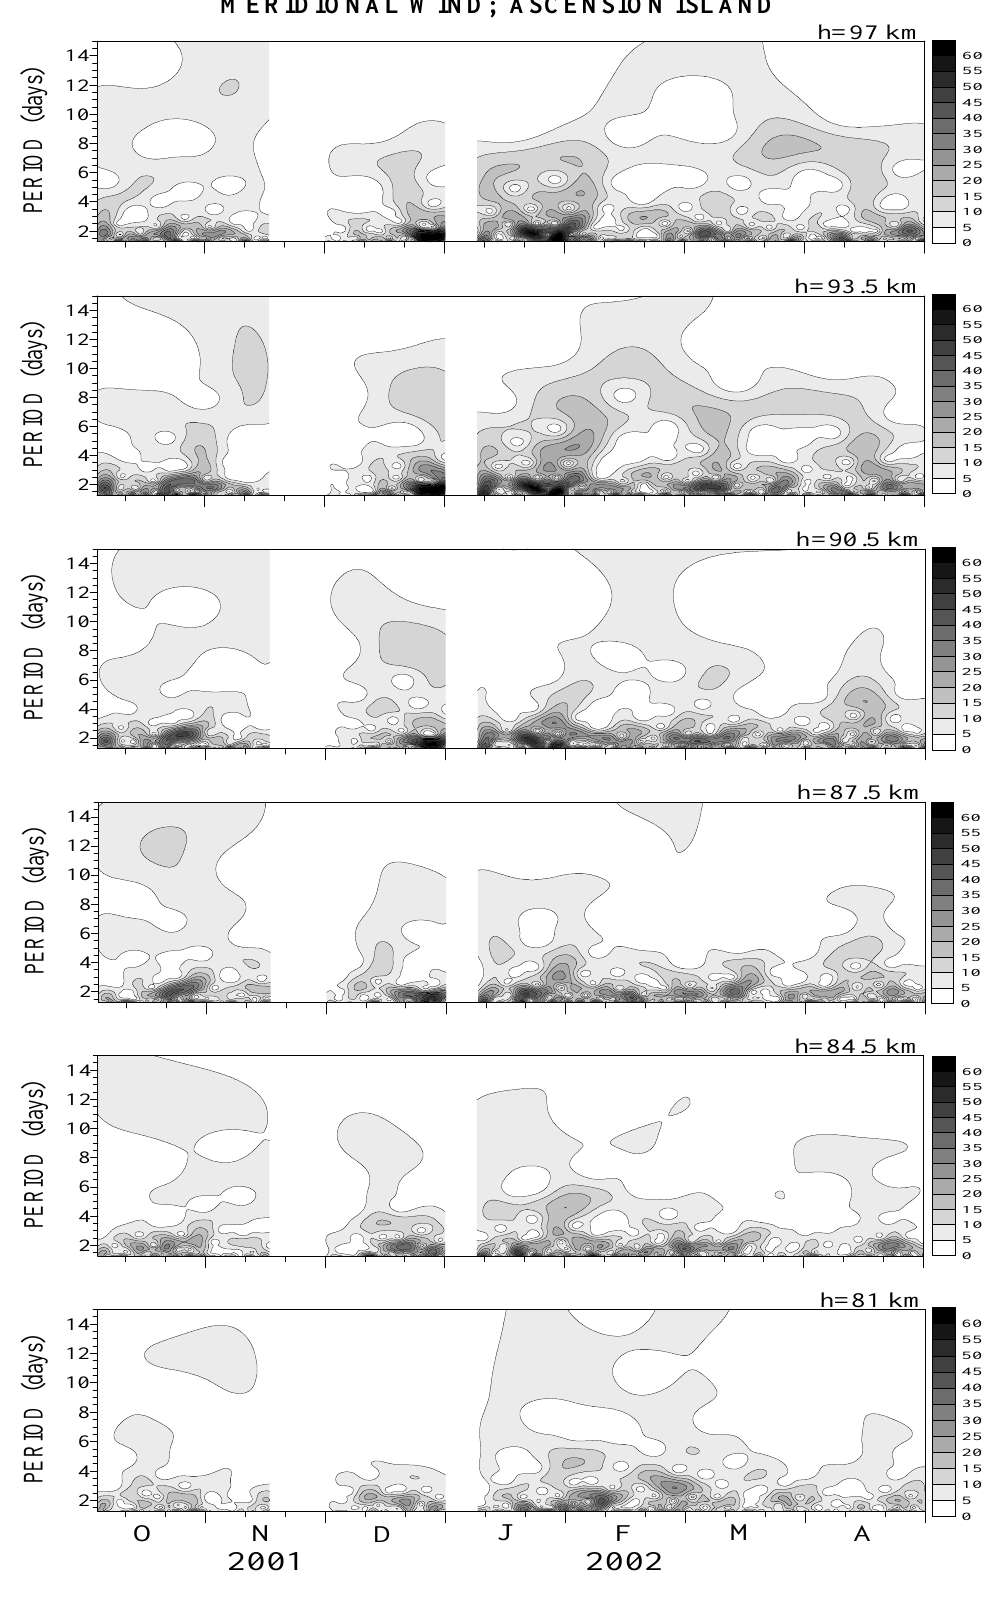
Fig. 2b. The same as Fig. 2a, but for the meridional